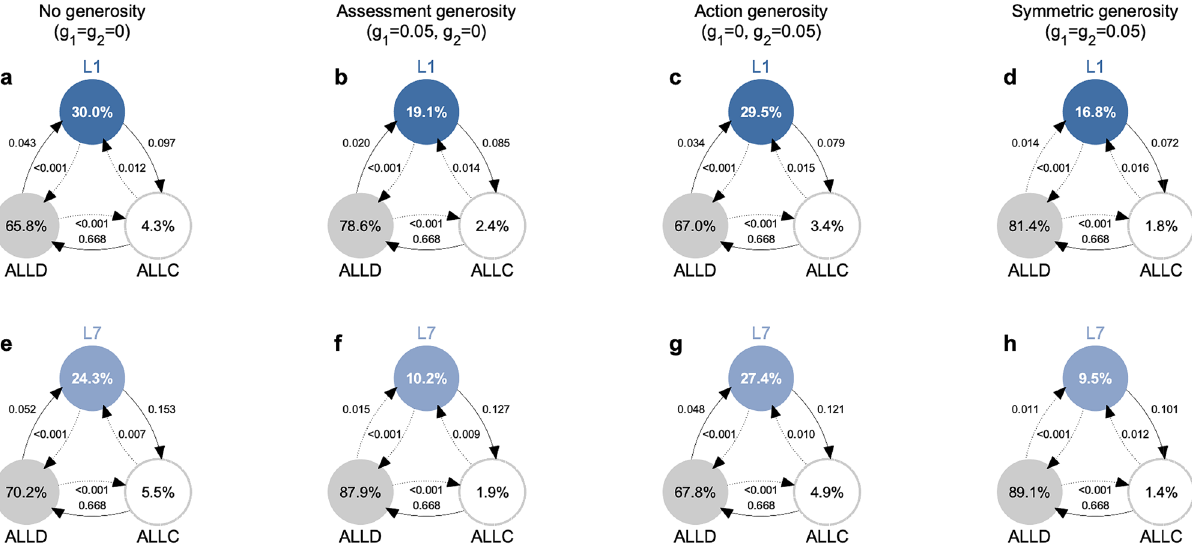
Figure 4. Evolution of the leading eight under assessment and action generosity. We simulate the evolutionary dynamics when players can choose among three different norms, a leading eight norm, ALLC , and ALLD . Social norms spread in the population according to a pairwise comparison process 45 , such that norms of players with high payoffs are more likely to spread. Here we depict results for the limit of rare mutations, such that populations are homogeneous most of the time 50–52 . Numbers in circles show how often each social norm is adopted on average. Arrows indicate how likely other social norms can invade a given resident population. Solid arrows indicate that the respective transition is more likely to occur than expected under neutrality, whereas dotted arrows indicate that the respective transition is comparably unlikely. We consider four scenarios, depending on whether leading eight players exhibit no generosity, only assessment generosity, only action generosity, or both variants of generosity. ( a – d ) The norm L 1 is most abundant without any generosity. ( e – h ) The norm L 7 is most abundant with action generosity. However, even in that case, it is played in less than 30% of time. Parameters: N = 50 , ε = 0.05 , b = 5 , c = 1 , q = 0.9 , using a strength of selection of s = 1